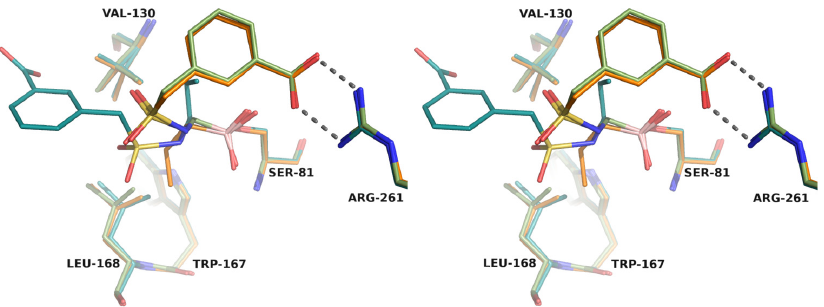
Figure 7. Stereoview superposition of OXA ‐ 24/40 complexes with CR167 (smudge green), 6d (orange), and 6e (cyan). The conformation of 6d closely matches that of CR167 , and carboxylate groups form an interaction with Arg261 (gray dashed lines). Val130 can be observed in alternate conformations for 6d and 6e but only in a single conformation for CR167 , suggesting that the ethyl substituent may clash with the side chain of Val130. Val130, Trp167, and Leu168 form a hydrophobic pocket. The Tyr112/Met223 (not shown) remains intact in all complexes.